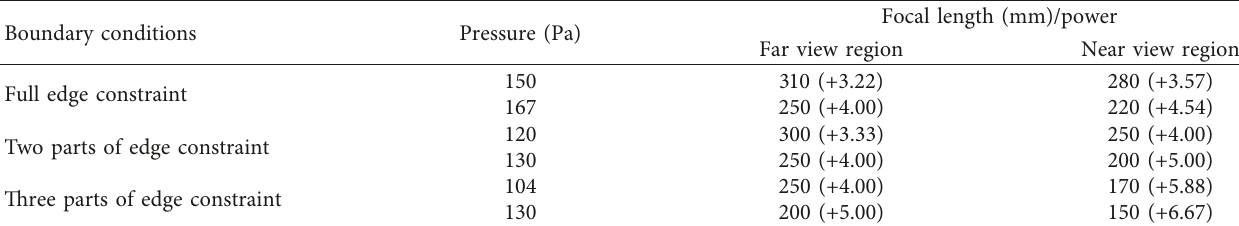
Table 1: The relationship of liquid pressure and focal length of three kinds of liquid lenses. Boundary conditions